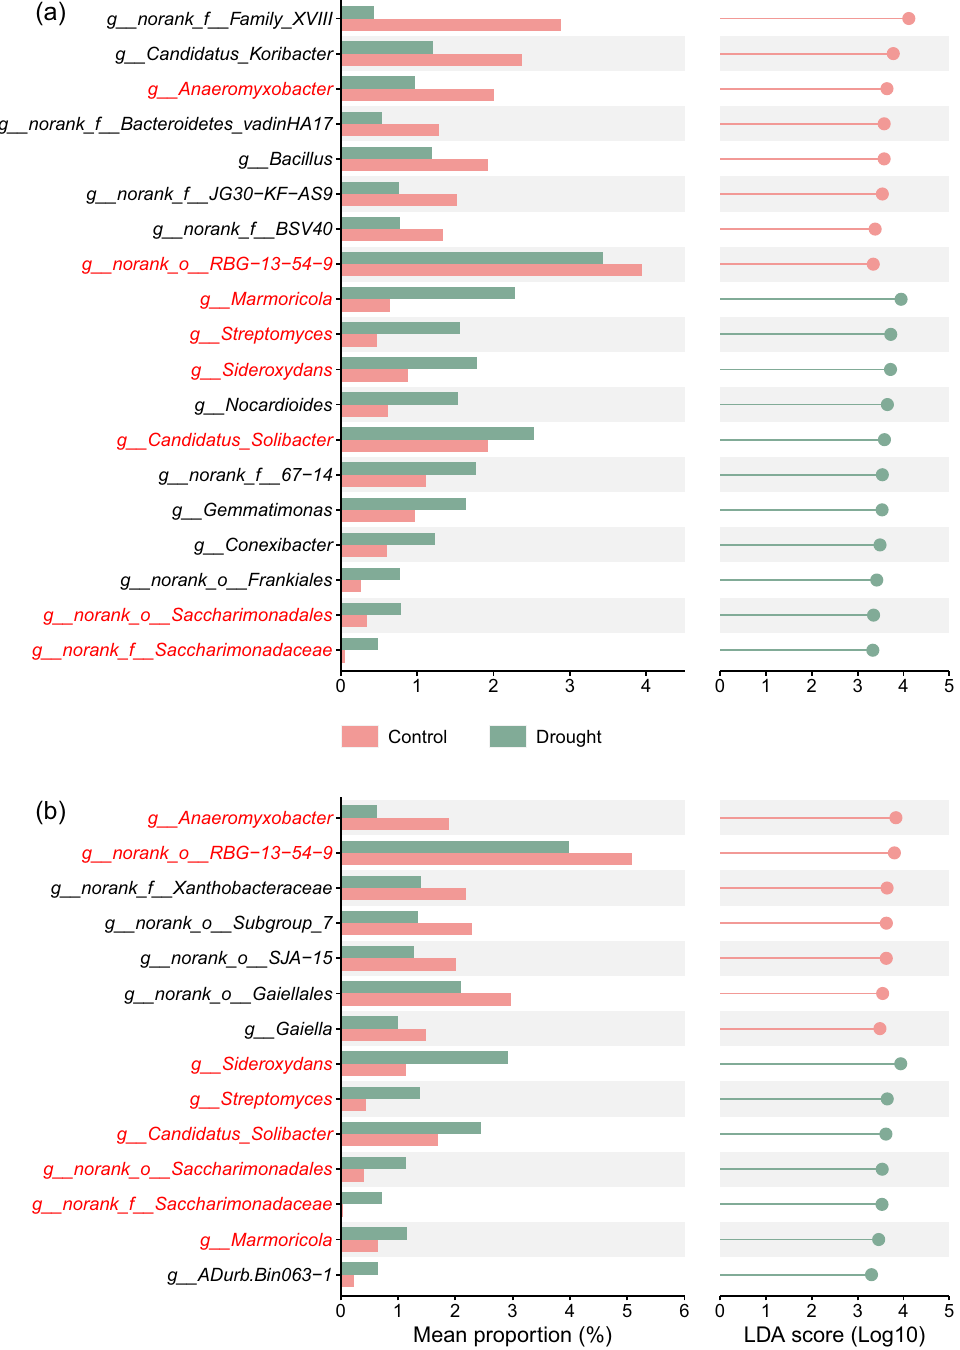
Fig. 3 Differentially abundant genera identified by LEfSe with logarithmic LDA > 3.3 in response to different watering treatments in a Nipponbare and b Luodao 998. The abscissa on the left represents the mean relative abundance of a certain genus under different treatments, and the ordinate represents the name of the genus. The name of the genus marked in red denotes that the genus is shared by the two rice genotypes. The length of the line on the right reflects the LDA value, and the color of the nodes and lines indicates that the genus is significantly enriched in the corresponding watering